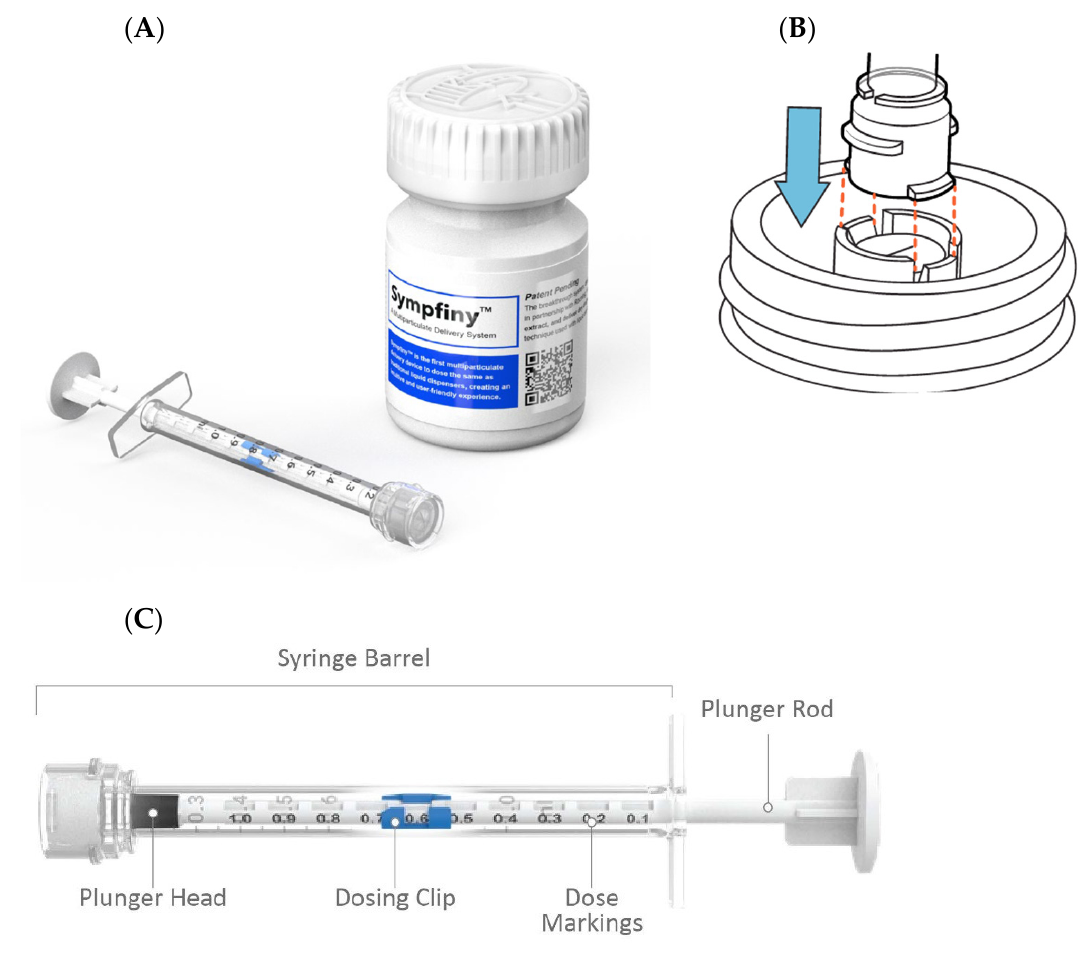
Figure 1. ( A ) Sympfiny ® System: Syringe and Bottle; ( B ) Syringe to bottle adaptable geometry; ( C ) Syringe components including dosing clip .